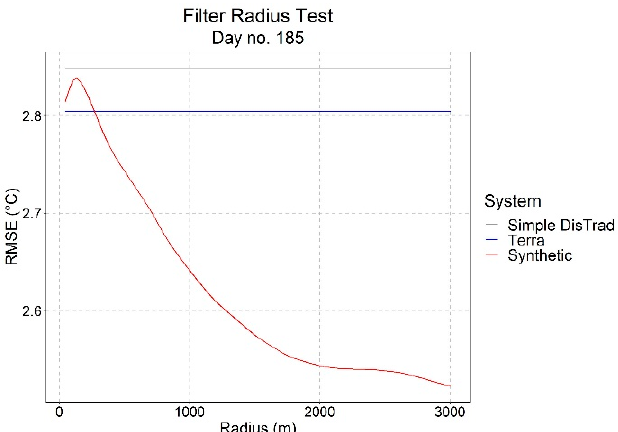
Figure 8. Selection of optimal filter length for low and high bandpass filters. For calculation expedi- ency, the analysis is performed on the transect rather than the entire image.